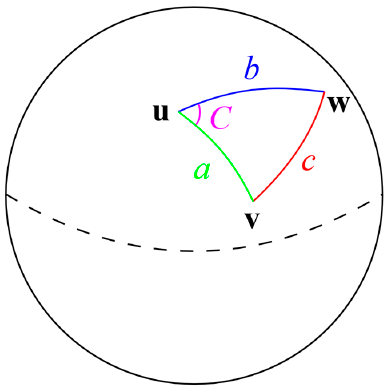
Figure 3. Spherical triangle determined by the law of haversines. u, v, and w: three point on the sphere; a : length (from u to v); b : length (from u to w); c : length (from w to v); C : the angle of the corner opposite c .